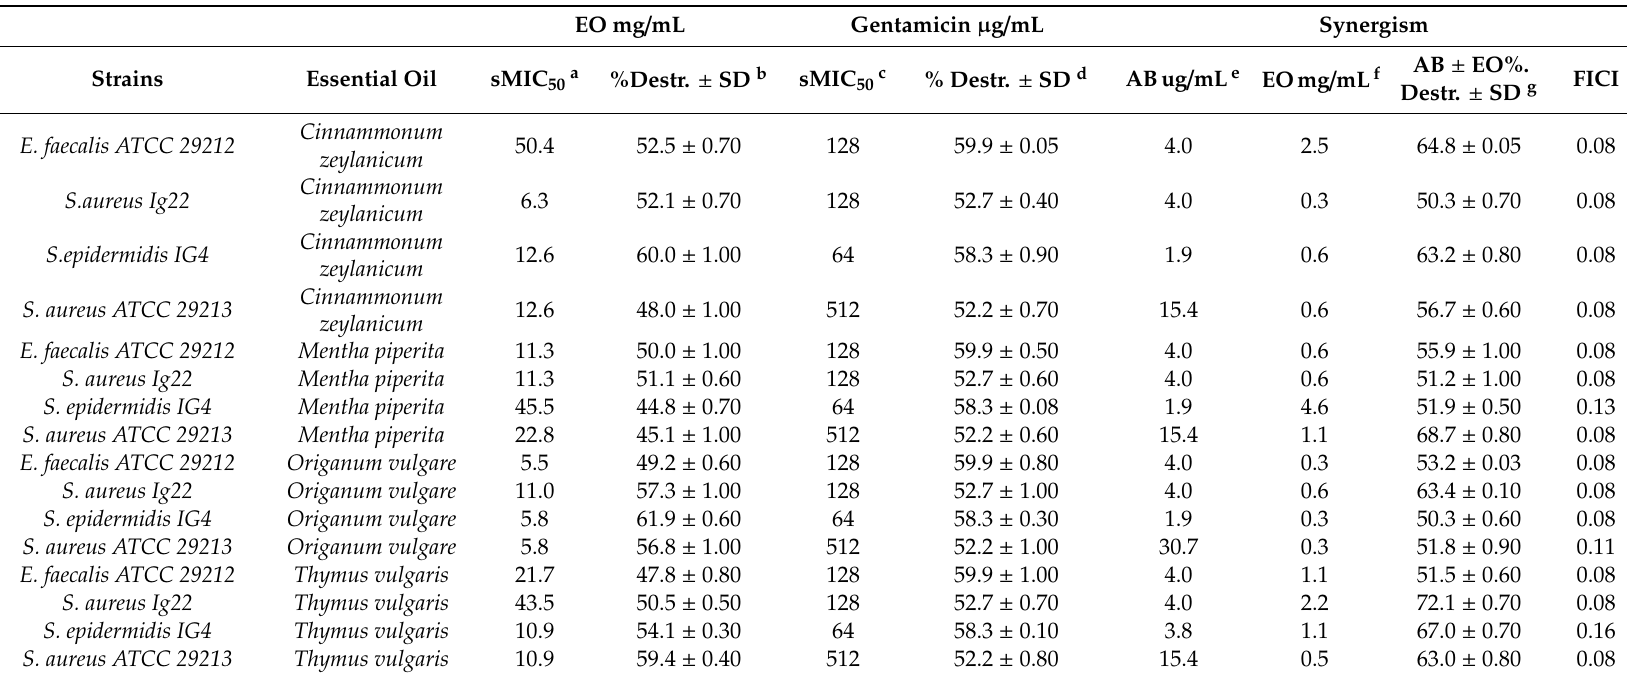
Table 2. Destruction e ff ect of di ff erent EOs alone and in combination with gentamicin on mature